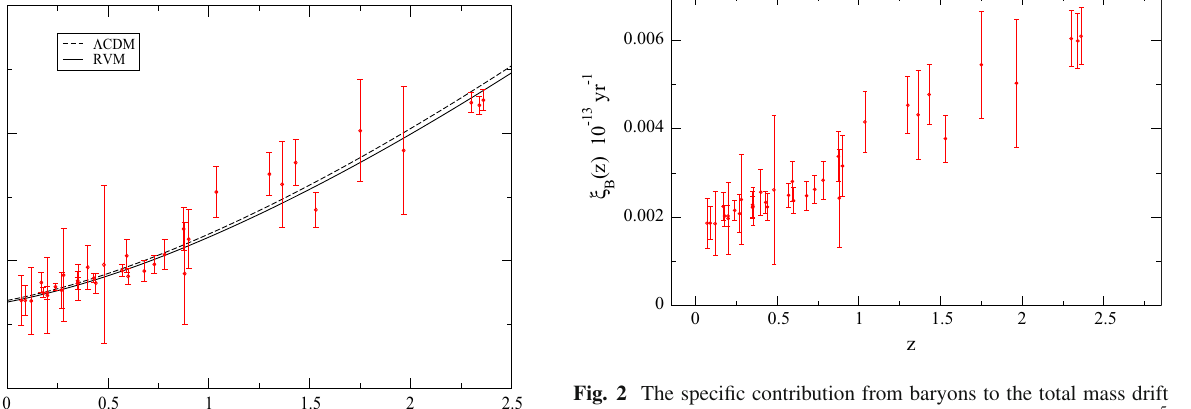
Fig. 2 The specific contribution from baryons to the total mass drift rate. We plot the dimensionless function ξ B from (22) for ν B = 10 − 5 using the H ( z ) data of Fig. 1 (see text)